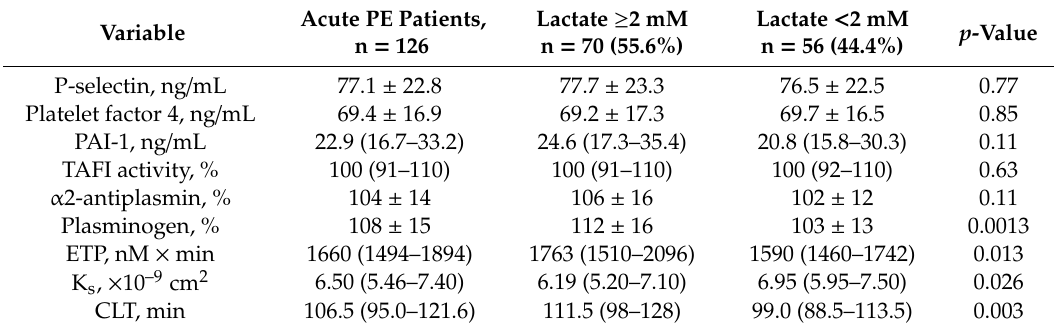
Table 2. Platelet markers, fibrinolytic proteins, thrombin generation, and fibrin clot parameters in patients with acute pulmonary embolism (PE) stratified according to serum lactate levels.